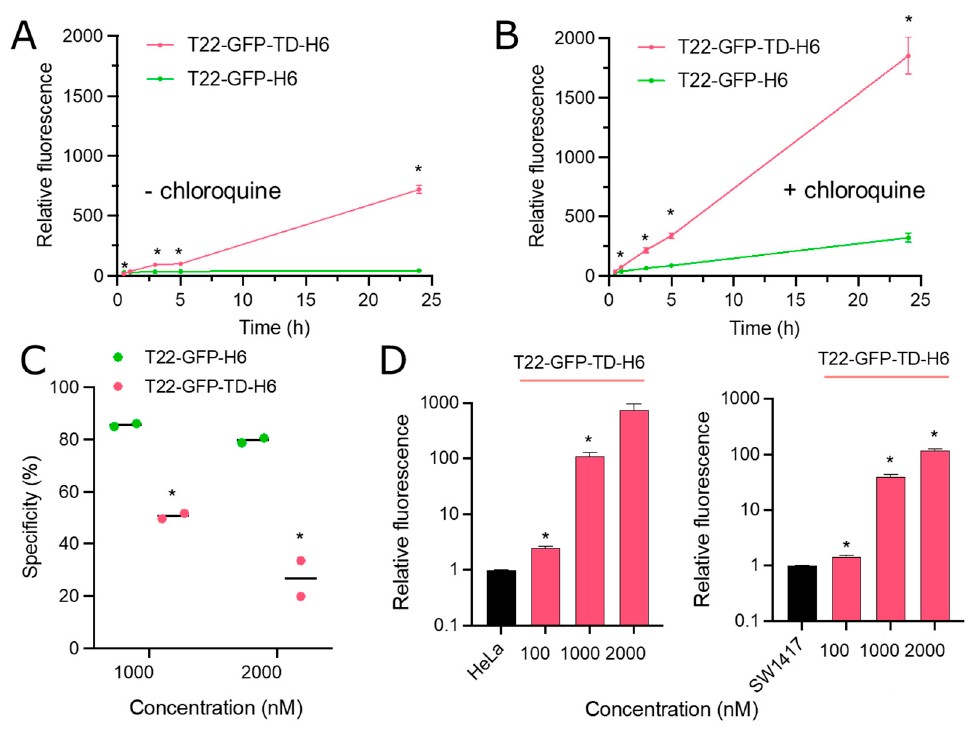
Figure 4. Cell interactivity and fate of T22 ‐ GFP ‐ TD ‐ H6 nanoparticles. ( A ) Time ‐ dependent intracel ‐ lular accumulation of T22 ‐ GFP ‐ H6 and T22 ‐ GFP ‐ TD ‐ H6 in HeLa cells. Both proteins (stored in 166 mM NaHCO 3 , 333 mM NaCl, pH 8.0) were incubated at 2000 nM. ( B ) Intracellular accumulation kinetics of T22 ‐ GFP ‐ H6 and T22 ‐ GFP ‐ TD ‐ H6 with chloroquine (0.5 M) incubated 4 h before protein addition. For comparison purposes, conditions tested were the same as in A. For both ( A , B ), fluo ‐ rescence values are referred to the background of non ‐ treated cells. Data are shown as mean ± stand ‐ ard error. Significant statistical differences between data pairs (T22 ‐ GFP ‐ H6 vs. T22 ‐ GFP ‐ TD ‐ H6 at a respective time) are represented by * at p < 0.05. ( C ) CXCR4 ‐ specificity of 1000 nM and 2000 nM T22 ‐ GFP ‐ H6 or T22 ‐ GFP ‐ TD ‐ H6 in HeLa cells, measured by cell internalization after 1 h of exposure. Cells were previously incubated with the CXCR4 antagonist AMD3100 at ten ‐ fold the protein con ‐ centration (10 μ M or 20 μ M). Data are shown as mean ± standard error. Statistical significance be ‐ tween T22 ‐ GFP ‐ H6 and T22 ‐ GFP ‐ TD ‐ H6 specificity is represented by * p < 0.05. ( D ) Intracellular fluorescence of CXCR4 + HeLa cells and CXCR4 − SW1417 cells exposed to T22 ‐ GFP ‐ TD ‐ H6 for 24 h. Fluorescence values are referred to the background of non ‐ treated cells. Data are shown as mean ± standard error. Significant statistical differences between values at each condition and background fluorescence of untreated cells are represented by * at p < 0.05.